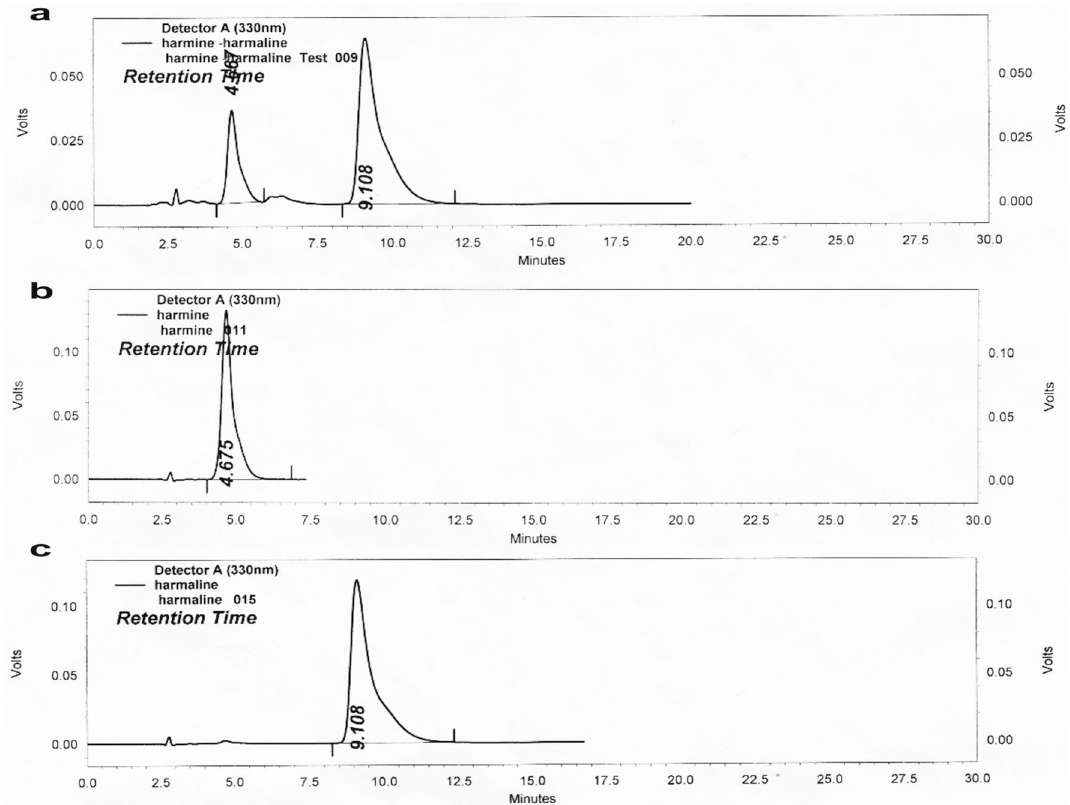
Figure 2. HPLC chromatogram. Graph represents ( a ) P. harmala extract against standard ( b ) harmine and ( c ) harmaline at 330